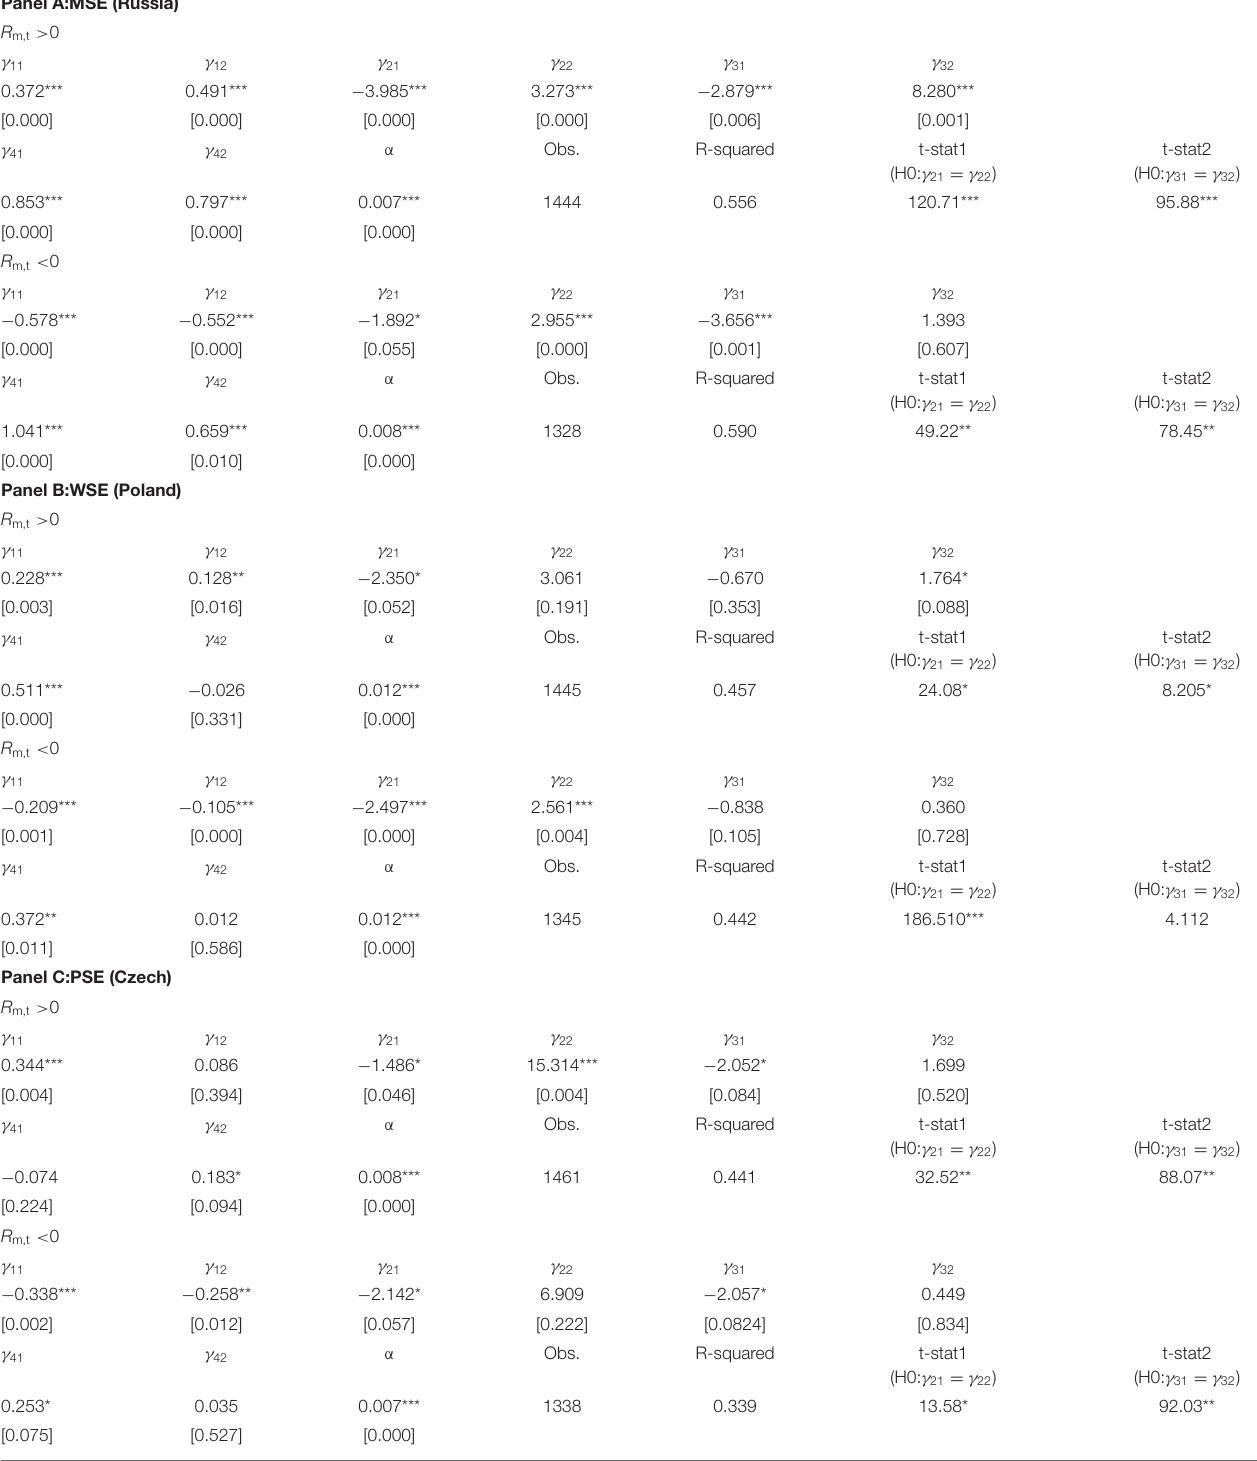
TABLE 4 | Effect of COVID-19 on herding behaviour in Eastern Europe markets for asymmetric effects. Panel A:MSE